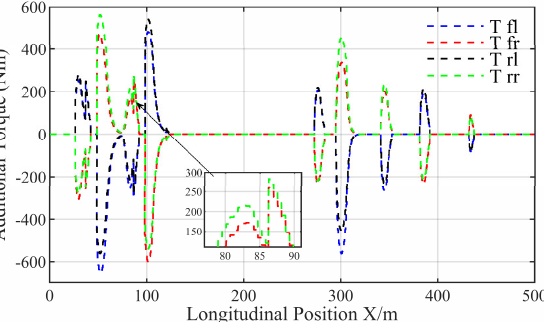
Figure 17. Additional torque of the path tracking stability controller at higher speed ( 110km/h